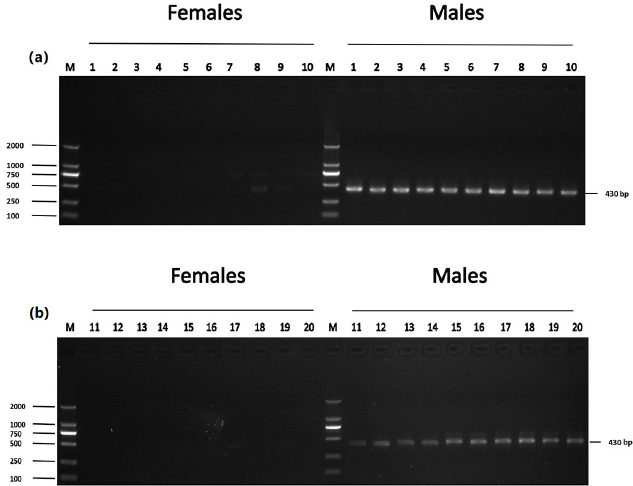
Fig 6. Identification of a male-specific tag, DNA fragment, amplified with Tag8818409. The left shows DL 2000 DNA marker sizes; the right shows fragment sizes.